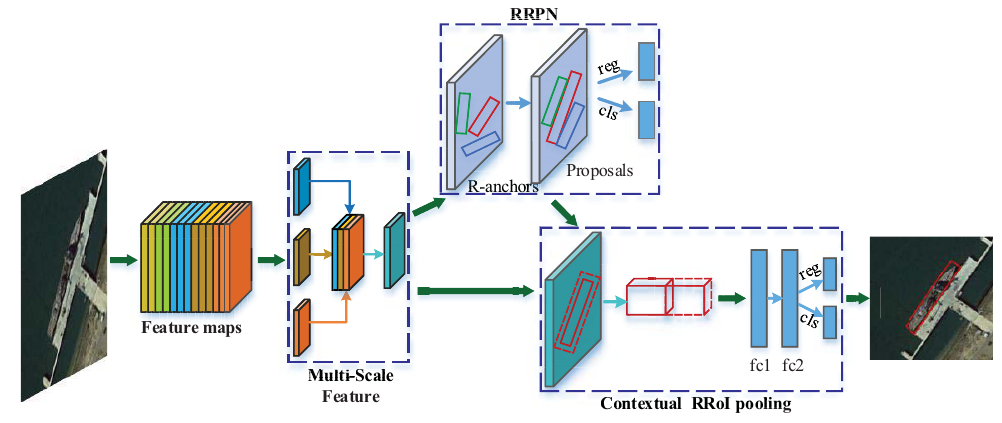
Figure 2. Overall framework of our proposed